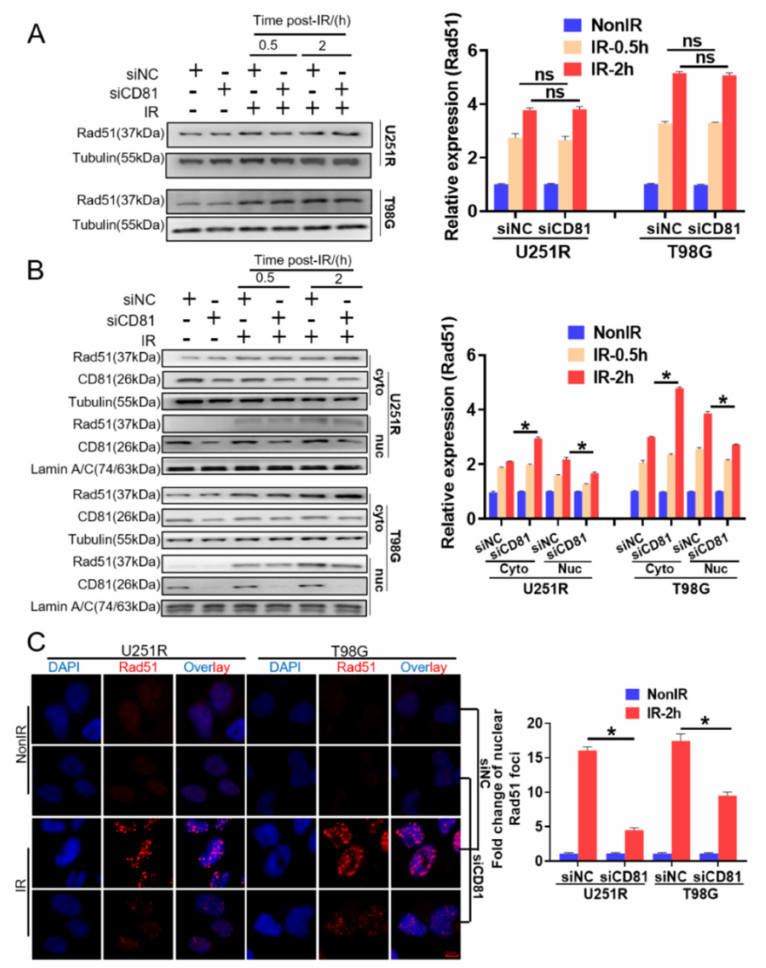
Figure 4. Suppression of CD81decreased nuclear translocation of Rad51 after 6 Gy irradiation. U251R and T98G cells were transfected with siNC and siCD81, respectively. ( A ) Western blot analysis ( left ) and quantitation ( right ) of cellular Rad51 level at 0.5 and 2 h post-IR. ( B ) Western blot analysis ( left ) and quantitation ( right ) of cytoplasmic (cyto) and nuclear (nuc) Rad51 level at 0.5 and 2 h post-IR. ( C ) Immunostaining images (left) and quantification (right) of nuclear Rad51 foci at 2 h post-IR. Blue, DAPI stained nuclear. Red, Rad51 foci. *, p < 0.05 between indicated groups. ns, no significant difference ( p > 0.05 between indicated